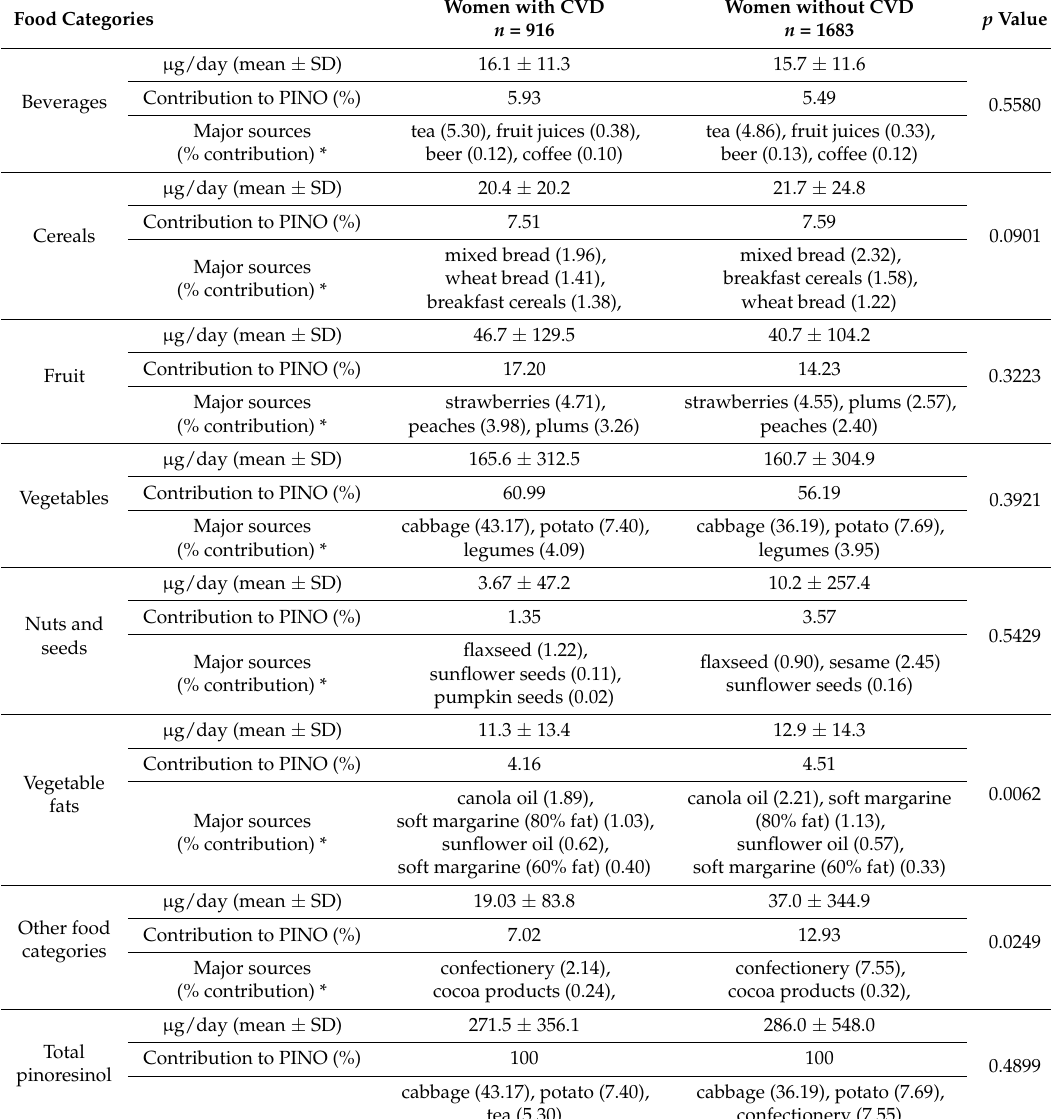
Table 4. Contributions of food categories and individual food products to pinoresinol (PINO) intake in women with and without